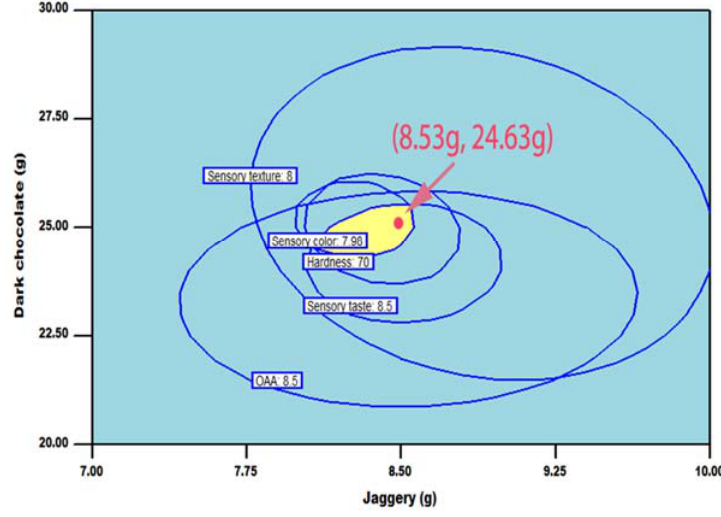
Figure 3. Superimposed counter plots for sensory and textural responses as affected by the levels of jaggery and chocolate.